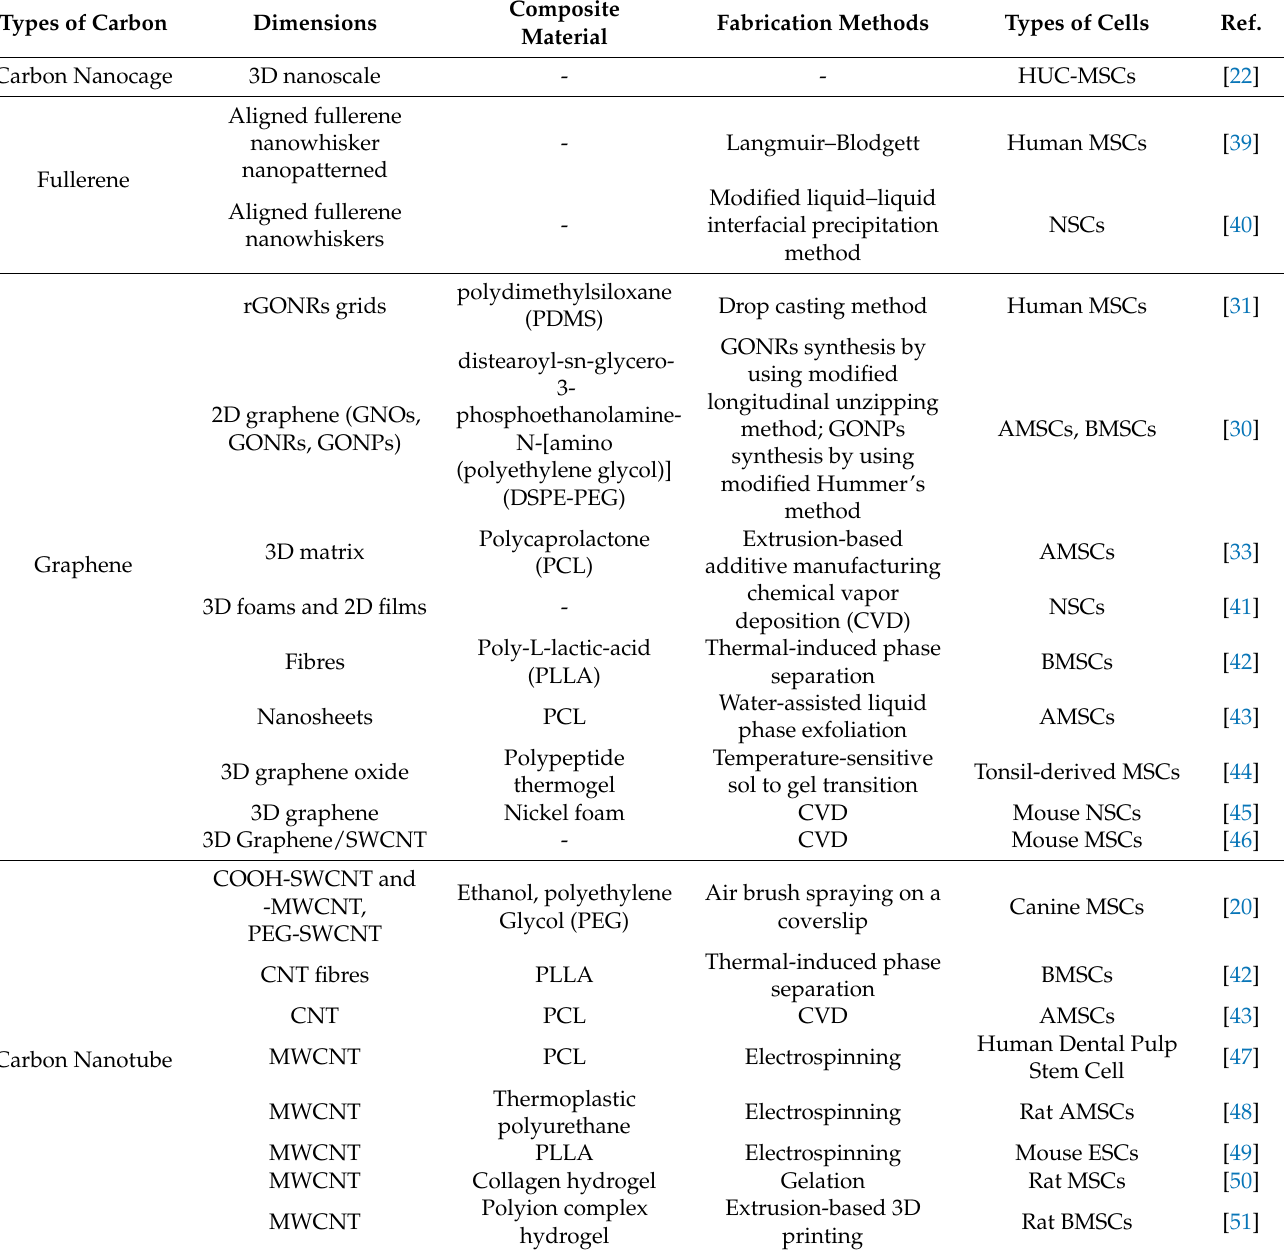
Table 1. Carbon materials application in SCs and other biological cells